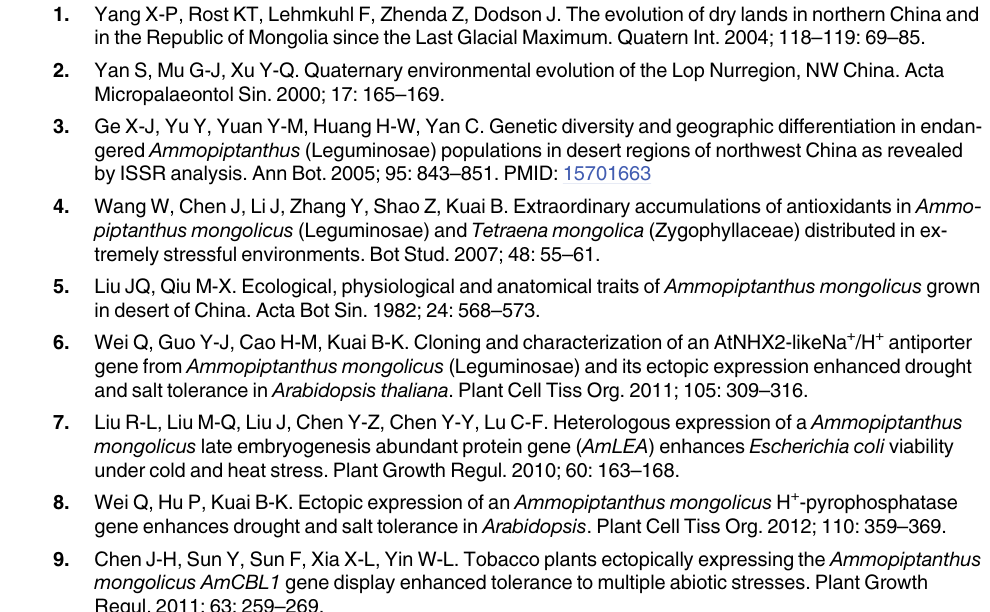
S3 Fig. Relationship between the number of detected genes and sequencing amount. When the sequencing amount reaches 6 million or higher, the growth curve of detected genes flattens, indicating that the number of detected genes tends to saturation. S4 Fig. Gene expression levels revealed by qRT-PCR (red column) and RNA-Seq (blue col- umn). Data from qRT-PCR are means of three replicates and bars represent SE. S5 Fig. KEGG enrichment analysis revealed that multiple hormones signal transduction pathways were involved in the drought response in A . mongolicus leaves. The up-regulated genes are boxed in red and the down-regulated genes are boxed in green. (A) Auxin, (B) Cyto- kinine, (C) Gibberellin, (D) Abscisic acid, (E) Ethylene, (F) Brassinosteroid, (G) Jasmonic acid, and (H) Salicylic acid. S1 Table. Primer sequences used for qRT-PCR analysis. S2 Table. GO enrichment analysis of the DETs during drought treatment. S3 Table. KEGG enrichment analysis of the DETs during drought